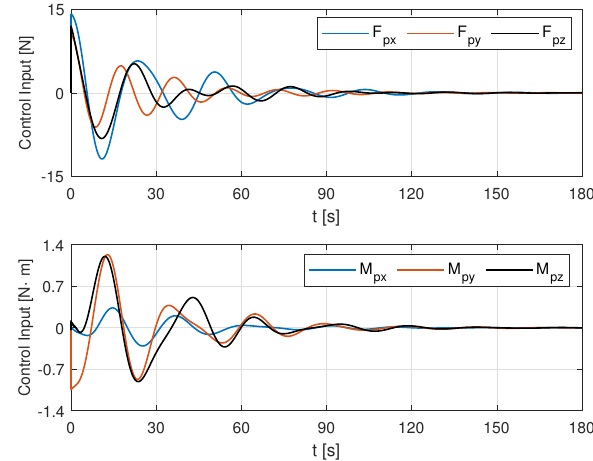
Figure 12. Actuator forces and moments.